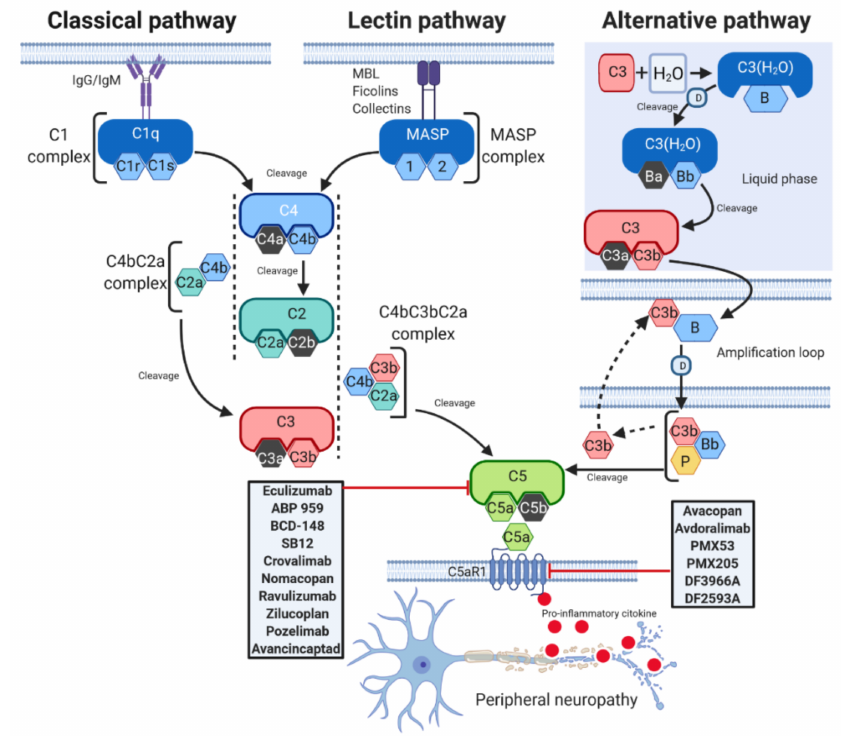
Figure 1. C5a complement activation pathways. The C5a complement system can be activated through three pathways: classical (CP), lectin (LP), and alternative (AP). CP begins with antibody- mediated activation of C1 complex, which leads to formation of the C4bC2a complex, the C3 convertase. This C3 convertase cleaves C3 to produce C3b, which forms a complex with C4b and C2a. This complex is the C5 convertase, which cleaves C5 to produce C5a and C5b. The LP begins with signal recognition by oligomeric structures of mannose- binding lectin (MBL), ficolins and collectins, which activate mannan-binding lectin serine proteases (MASP) 1 and 2, which in turn mediate the production of C4b. From this point, the LP follows the same steps as the CP. In the AP, C3 interacts with factor B (B) and factor D (D), leading to cleavage of further C3, and this process is perpetuated through an amplification loop. In the final step of this pathway, even properdin (P) is involved. Additional C3b binds to the C3 convertase and forms a C5 convertase, which cleaves C5 to form C5a and C5b. C5a activates on C5aR1, a prototypical G-protein coupled receptor (GPCR) recruiting immune cells to the site of inflammation. Drugs targeting C5 or C5aR1 in different stage of development are reported in the gray rectangles. T-arrow indicates inhibition of pathway at point of